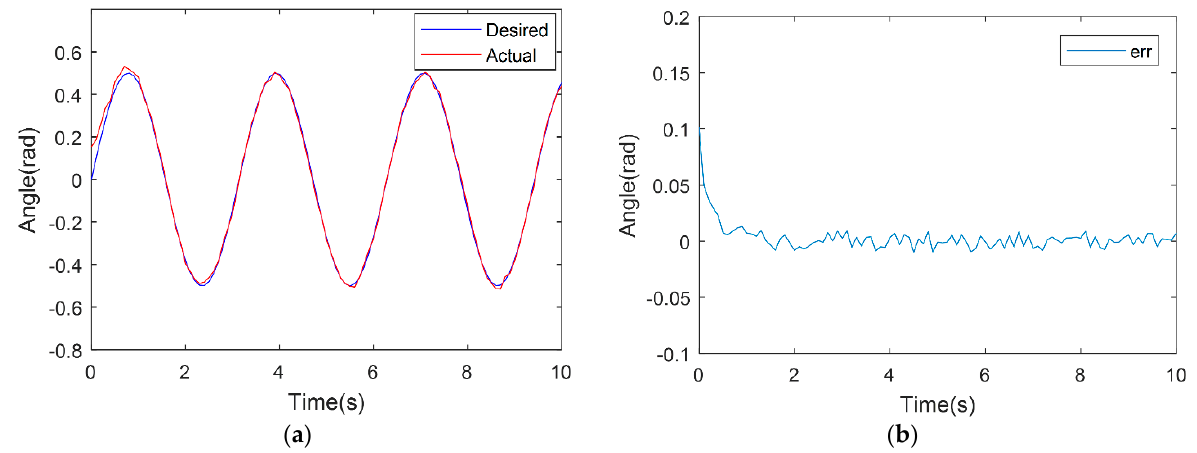
Figure 5. PD-based controller experimental result. ( a ) PD sinusoidal trajectory-tracking experiment results. ( b ) PD sinusoidal tracking experimental errors.